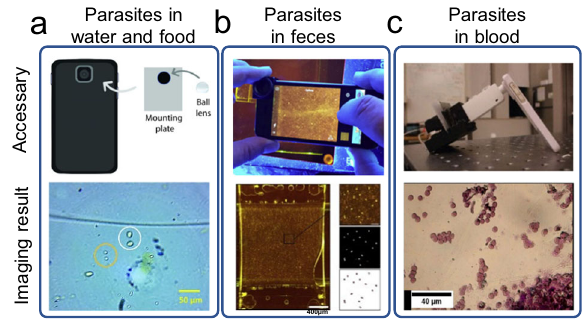
Fig. 10 | Detection of parasites on mHealth platforms. a Detection of Giardia cyst and Cryptosporidium (oo)cyst in food and water. The fi gure shows a representative image of (oo)cysts acquired by a smartphone microscope with a one mm ball lens and white LED light illumination ( fi gure adapted with permission from Shrestha et al. 198 ). b Detection of parasite eggs in feces. The fi gure shows an example of a whole- fi eld image of a sample in a McMaster chamber and image processing results during threshold segmentation ( fi gure adapted with permission from Slusarewicz et al. 199 ). c Detection of malaria in blood. The fi gure shows an image of the mouse malaria strain blood smear without polarized light using a Leica microscope with a ×40 magni fi cation objective ( fi gure adapted with permission from Pirnstill et al. 200